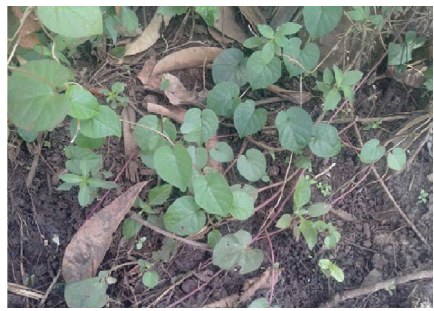
Figure 4: B. alba . Source: Field survey,